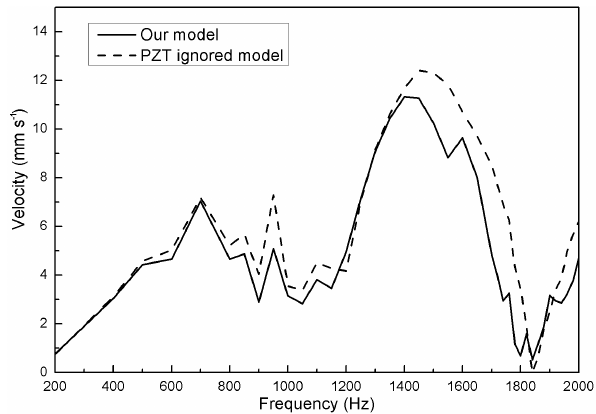
Figure 10. Displacements of the main body versus different friction coefficients.